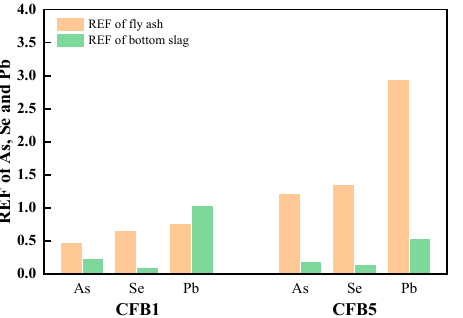
Figure 8. REFs of As, Se and Pb in fly ash and bottom slag of CFB1 and CFB5.